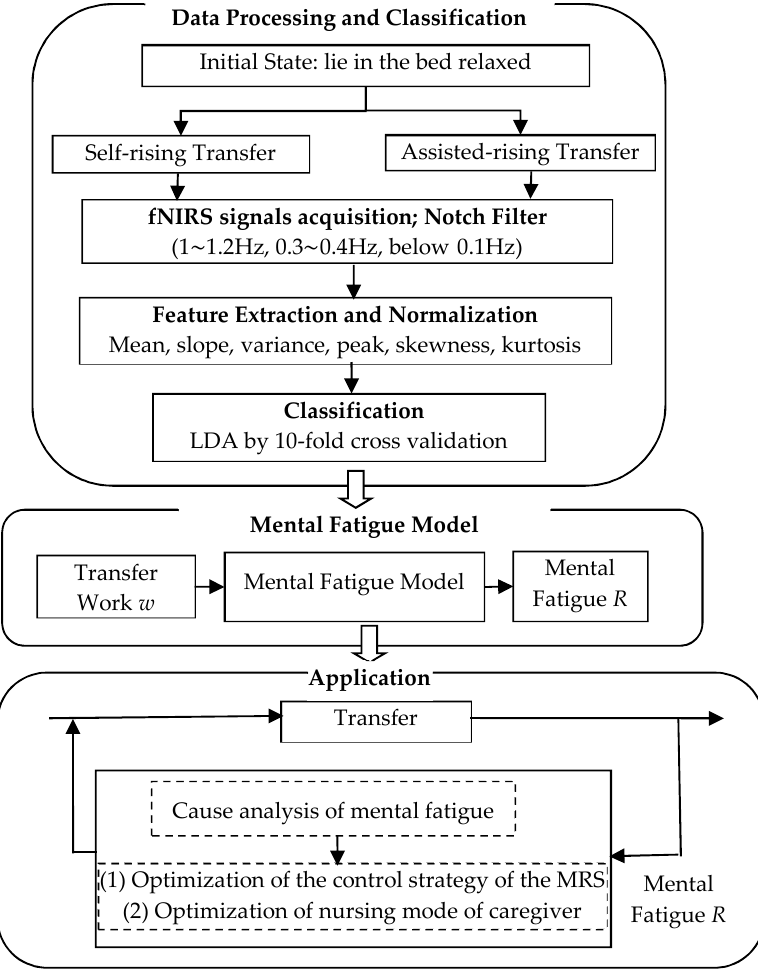
Figure 3. The block diagram of the whole system.